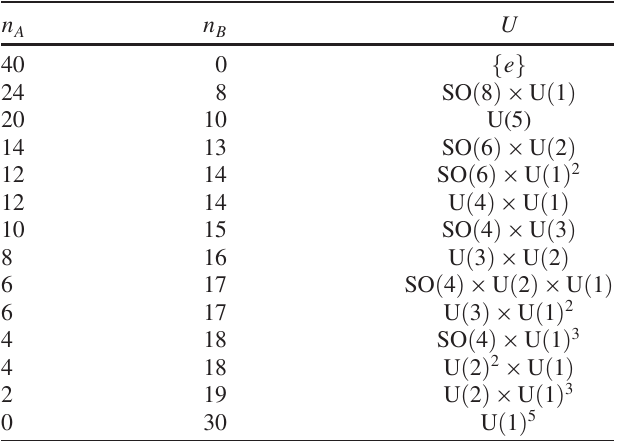
TABLE IV. Possible number of type- A and type- B NGBs for SO ð 10 Þ = U ð 1 Þ 5